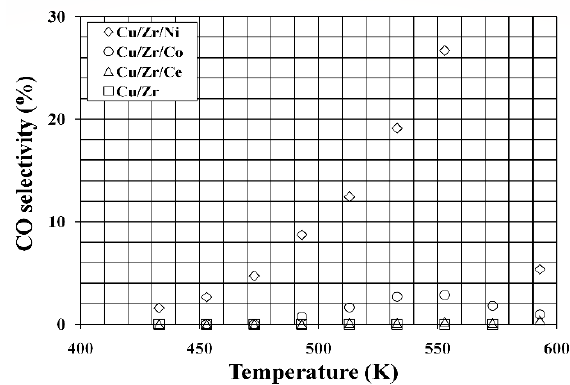
Figure 6. The effect of temperature on H 2 yield in ESR over tested catalysts.